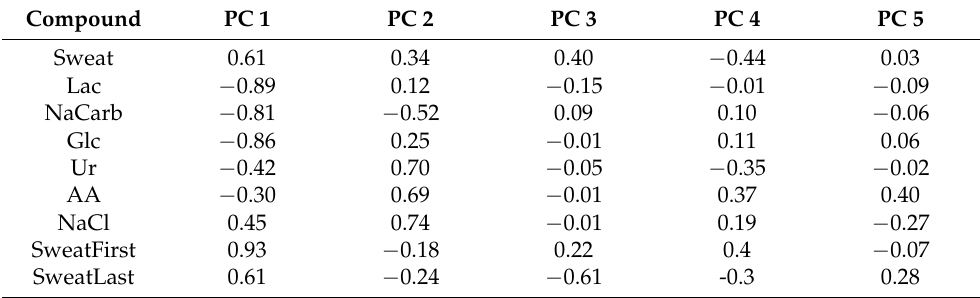
different compounds, and on-body measurements, obtained from the wearable e-tongue.